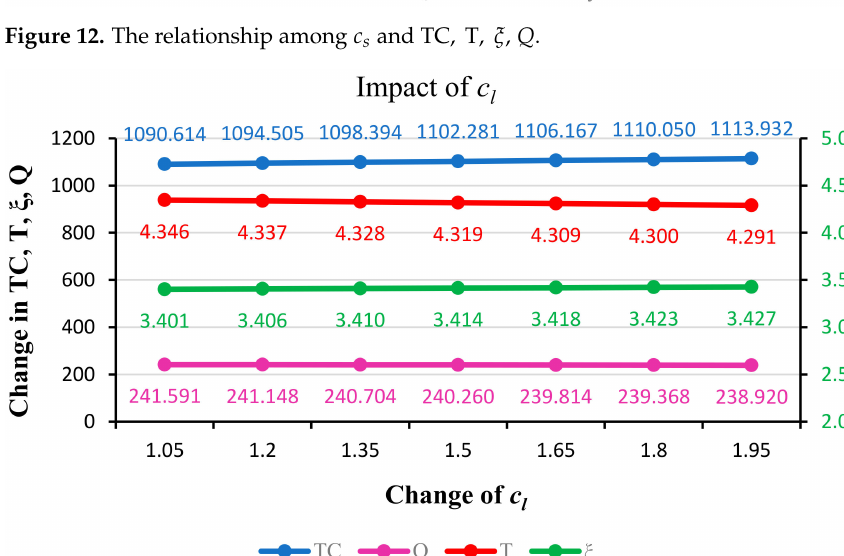
Figure 13. The relationship among c l and TC, T, ξ , Q